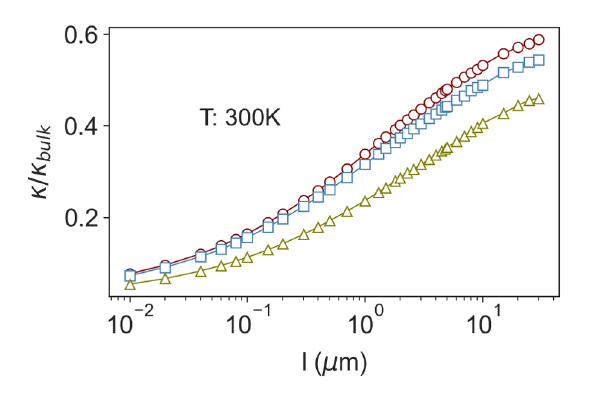
Figure A1. Fractional thermal conductivity vs. pore spacing for pores with different shapes of cylindrical in red, cubic in blue and triangular prism in green at 300